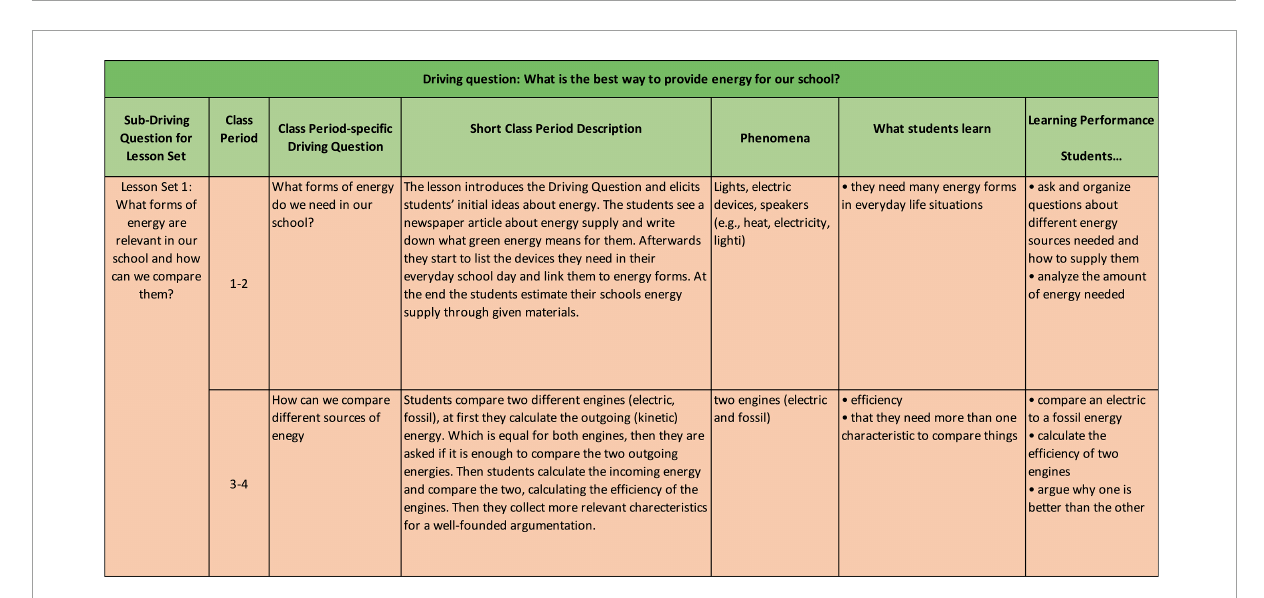
FIGURE7 Excerpt of the storyline for the physics learning